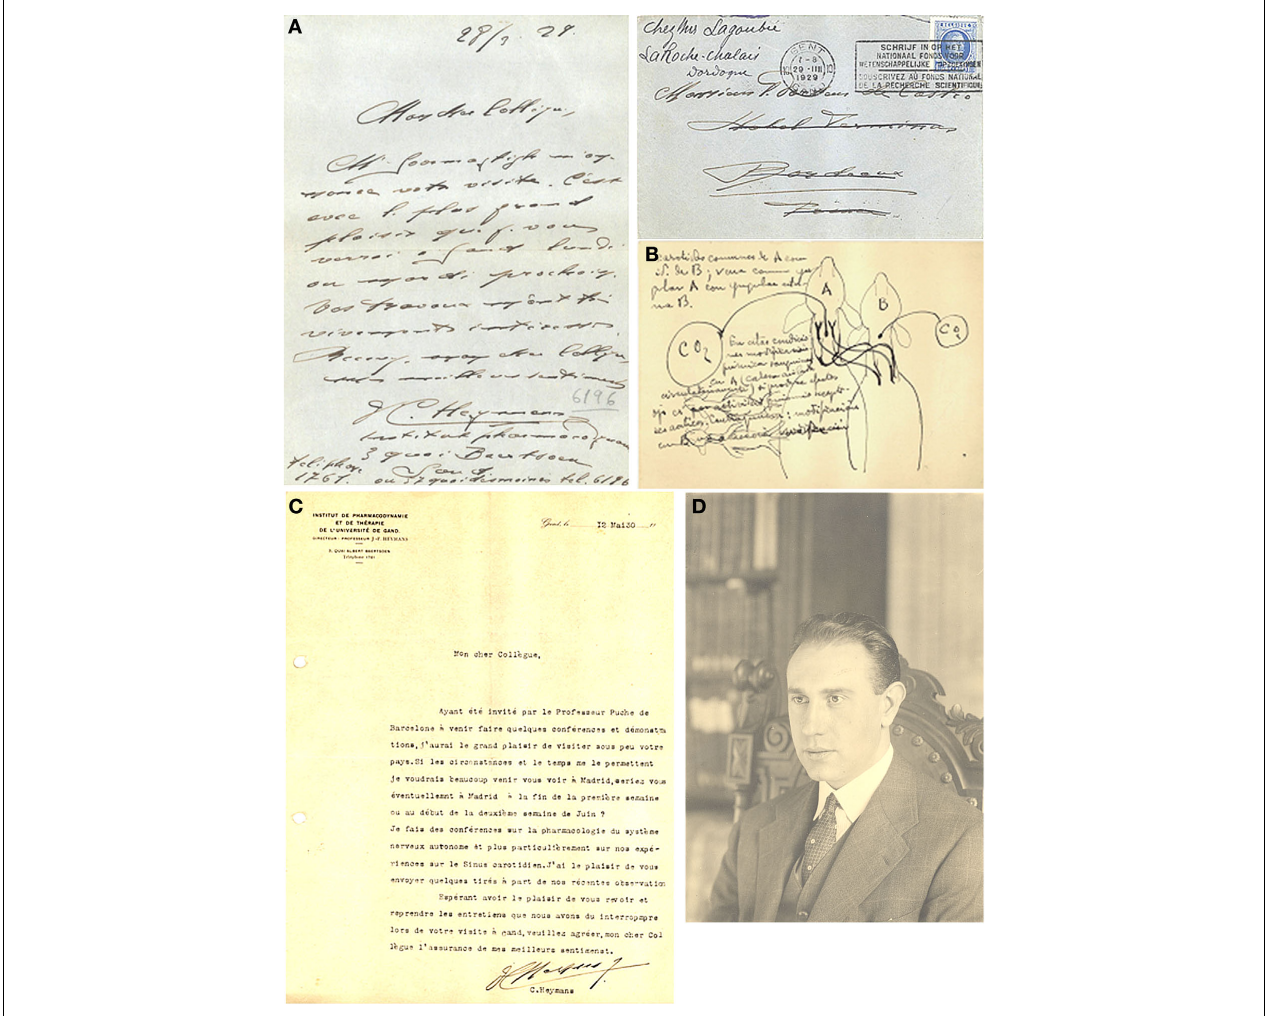
FIGURE 4 | Corneille Heymans refl ects on the work of Fernando De Castro on the innervation of the carotid sinus and carotid body. (A) Letter dated the 28th March 1929, in which Heymans invites Fernando De Castro to share experiences at his laboratory at Ghent University. The letter was sent to “Chez Lagoubie, La Roche-Chalais, Dordogne” (see envelop in upper-right corner), the family name of De Castro’s French brother-in-law where the Spanish histologist was staying for a few days after the meeting of the Association d’Anatomistes held in Bourdeaux (France; see text, for details). (B) De Castro’s sketch showing two dogs in parabiosis (the famous